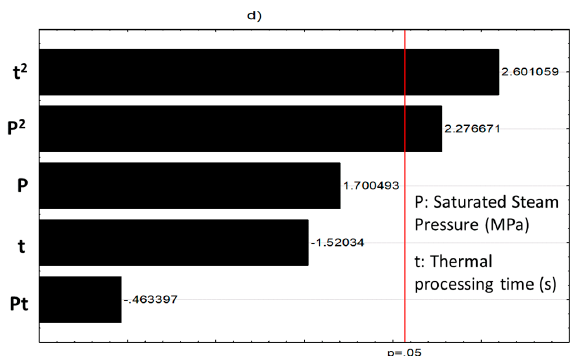
Figure 2. Pareto charts of significative effects on DIC treatments. ( a ) Total phenolics reduction, ( b ) Condensed tannins reduction, ( c ) IP 6 reduction, ( d ) Stachyose reduction.